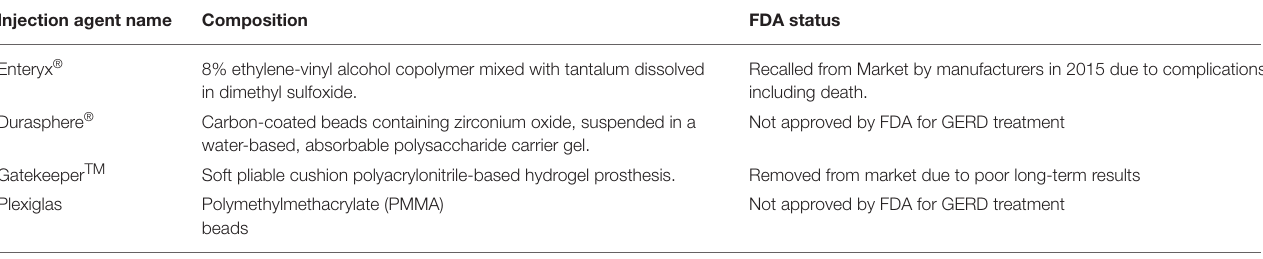
TABLE 2 | Different injectable agents used for endoscopic anti- reflux treatment.